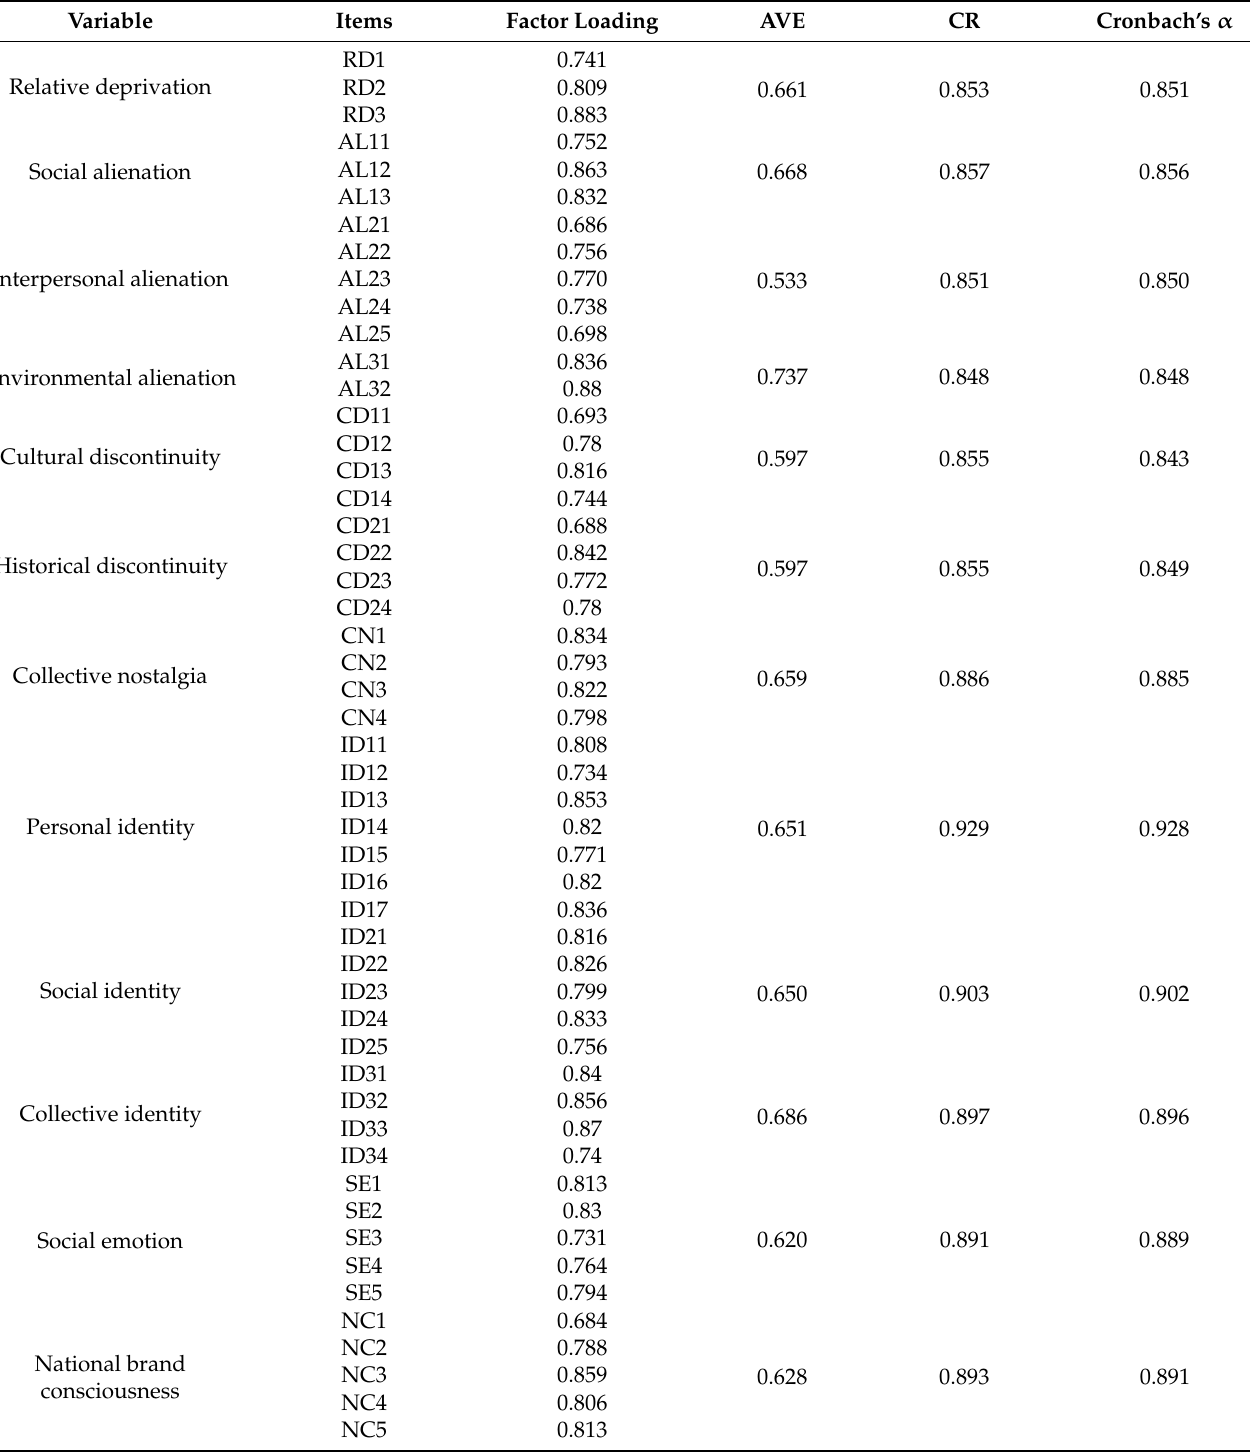
Table 2. Reliability and validity analysis of